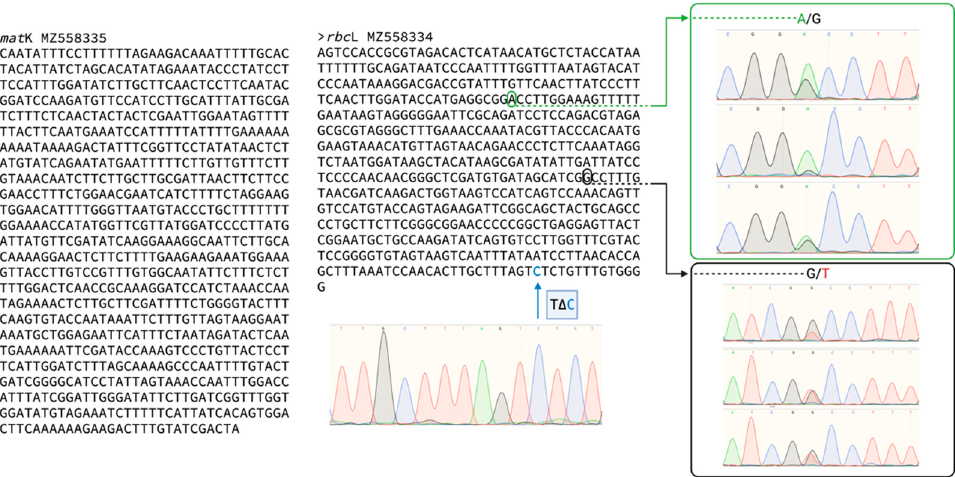
Figure 1. DNA markers used to identify the mat K and rbc L genes in non-irradiated Lazarroz FL rice variety. Note in green the synonymous SNP (C/T) and the biallelic synonymous mutations A/G and G/T (circled). None of the mutations had biological importance but helped in the genetic characterization of the cultivars.